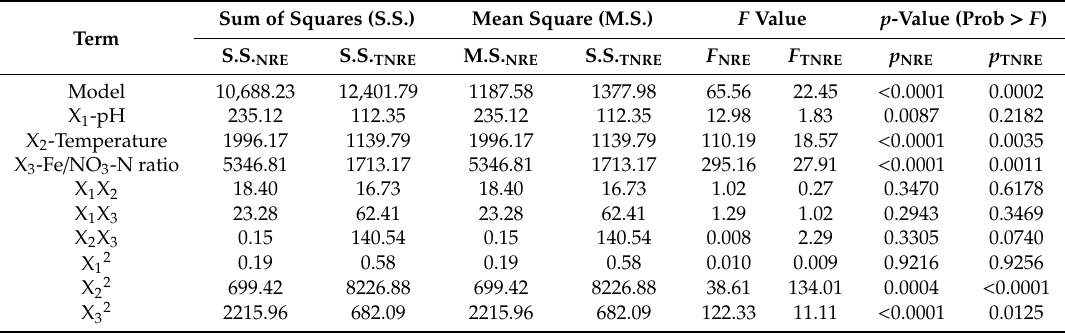
Table 2. The least squares fit and the parameter